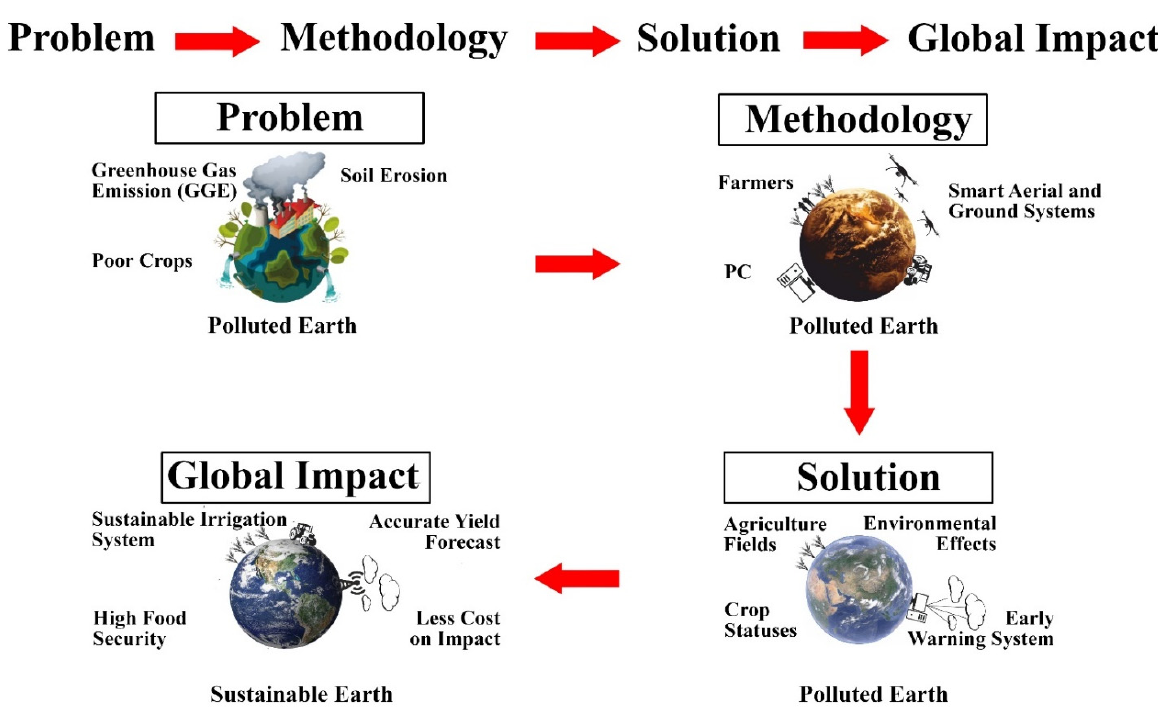
Figure 1. The graphical abstract visualizes the remote-sensing technology that perfectly addresses crop water stress using crop statistics and computer software by (1) identifying the problem, (2) implementing the methodology, (3) delivering the solution, and (4) addressing global crop water stress.